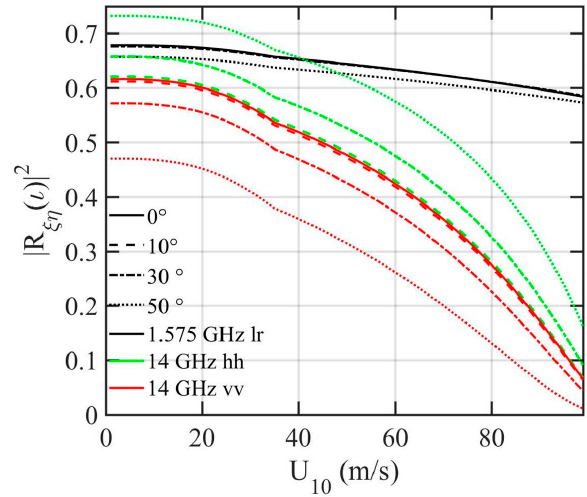
Figure 8. The sea surface reflectivity at 0°, 10°, 30°, and 50° incidence angles (solid, dashed, dashed–dotted, and dotted curves, respectively) for Ku (14 GHz, green and red curves) and L (1.575 GHz, black curves) bands. The GPSR signals are right-hand-circular transmit and left-hand-circular receive, so for L band | R lr ( ι )| 2 is given (black curves). For Ku band, the reflectivity for hh and vv polarizations is shown (green and red, respectively).